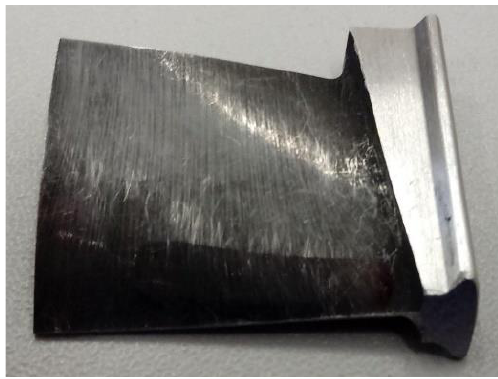
Figure 4. A blade before the griding operation.